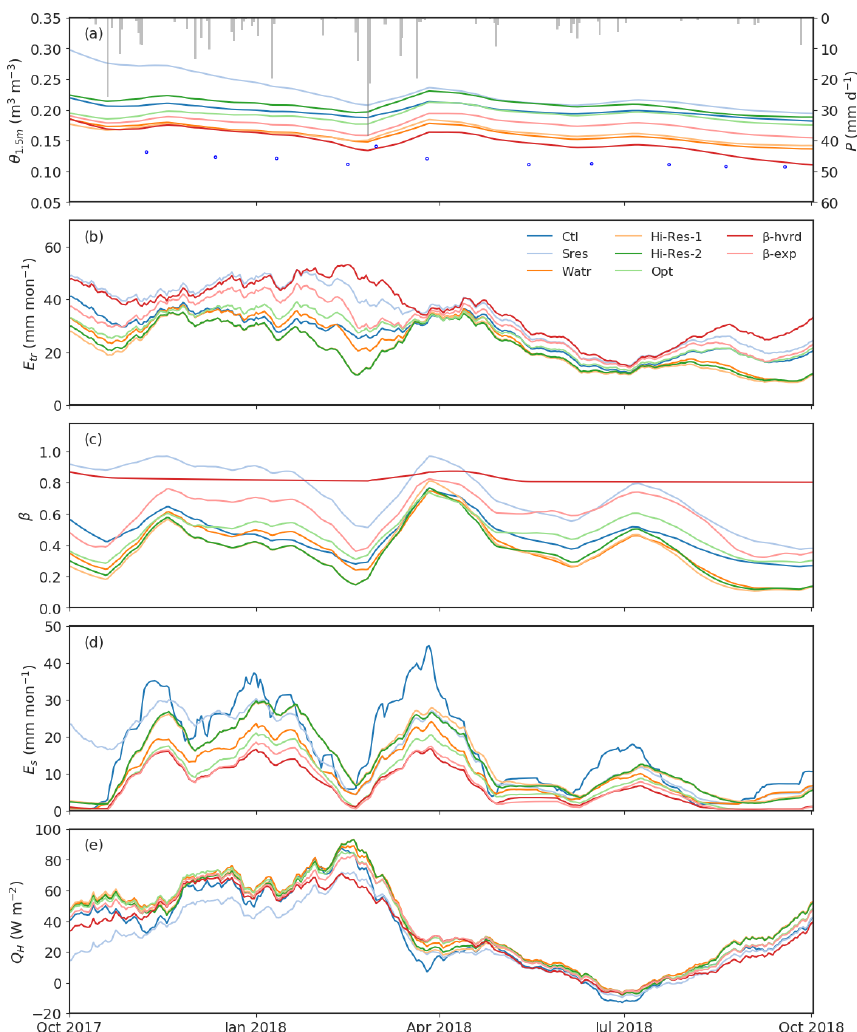
Figure 8. Simulations for each experiment during the drought period (October 2017 to September 2018). (a) The root-zone soil moisture over the top 1.5m ( θ 1 . 5m ) and rainfall ( P ; bars), with blue dots showing the observed soil moisture. (b) E tr , (c) water stress factor ( β ), (d) E s and (e) sensible heat ( Q H ). All lines are smoothed with a 30d